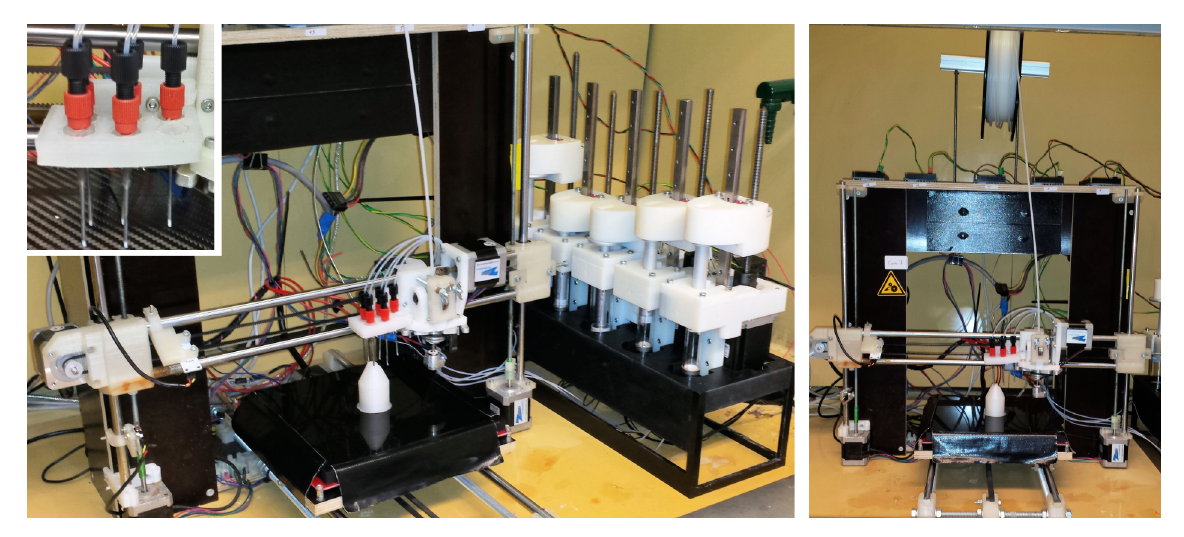
Figure 1: Prusa i3 RepRap printer modified for the automated synthesis of ibuprofen. Left: Full view of robotic platform set-up with a 3D-printed reac- tion vessel. Left inset: Dispensing needle carriage for 3D printing/liquid deposition. Right: Front view of the 3D-printing section of the robotic set-up with a 3D-printed reaction vessel showing the PP feedstock for reaction-vessel